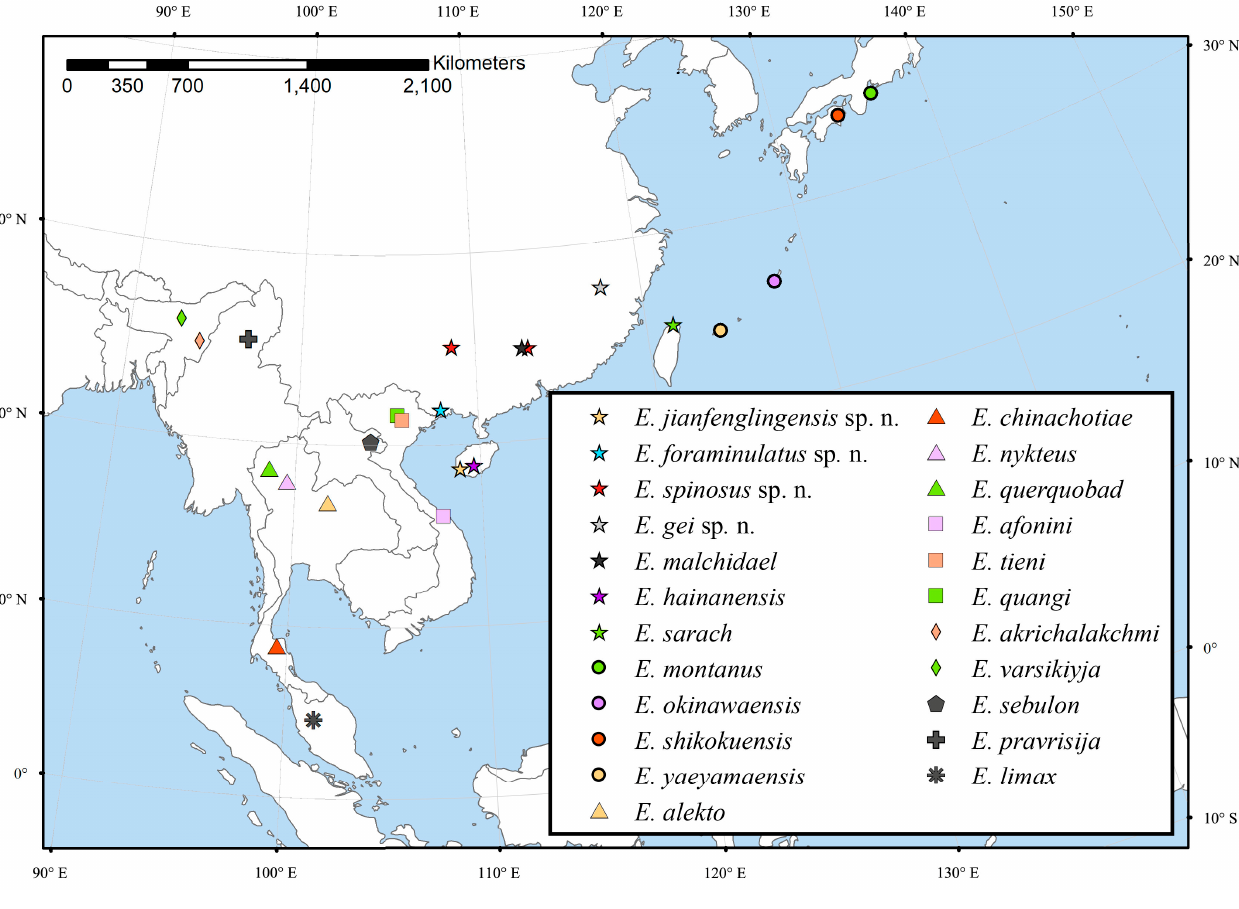
Figure 1. Distribution map of Eoneureclipsis species. 37 Table 1. World list of Eoneureclipsis